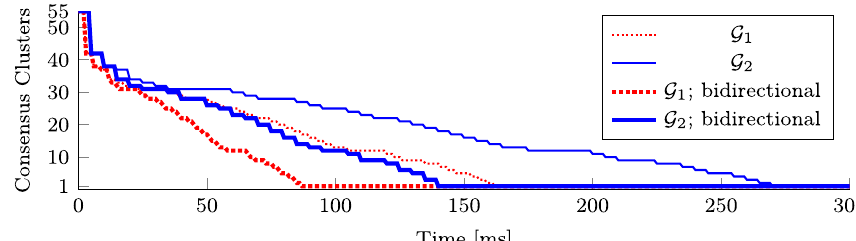
Fig. 6 Convergence time of (bidirectional) ring comparing centralized and meshed network